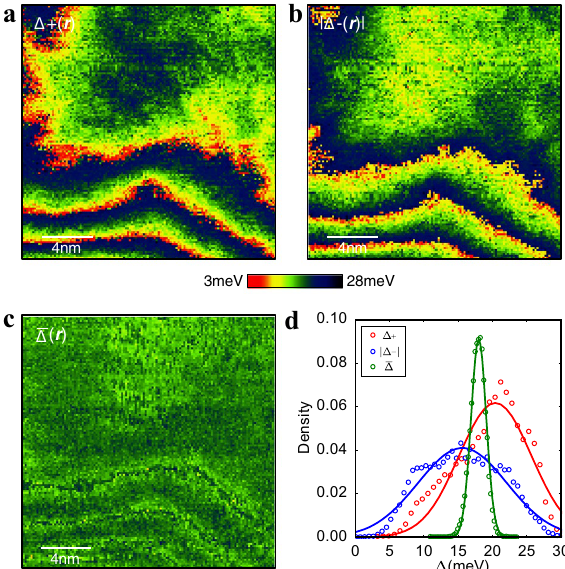
Figure 2. Gap maps and gap distributions. ( a and b ) Positive and negative energy gap maps. There is a clear anti-correlation between them. ( c ) Average gap map defined as (� + + | � − | )/ 2 , representing extremely uniform spatial variations. ( d ) Distributions of three gaps from a, b, and c. Solid curves are obtained by gaussian fittings to each distribution. The mean values for (cid:31) + , | (cid:31) − | , and (cid:31) are 20.4 meV, 15.6 meV and 18.1 meV,